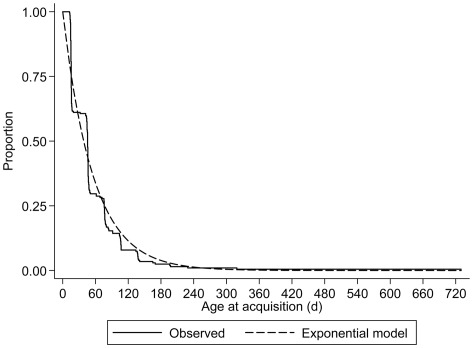
Observed and modeled age at first pneumococcal acquisition in the cohort of infants.